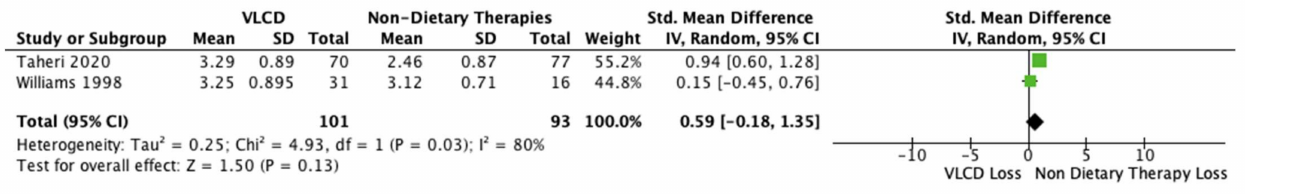
Figure 11. Forest plot showing mean LDL cholesterol after VLCD and non-dietary therapies